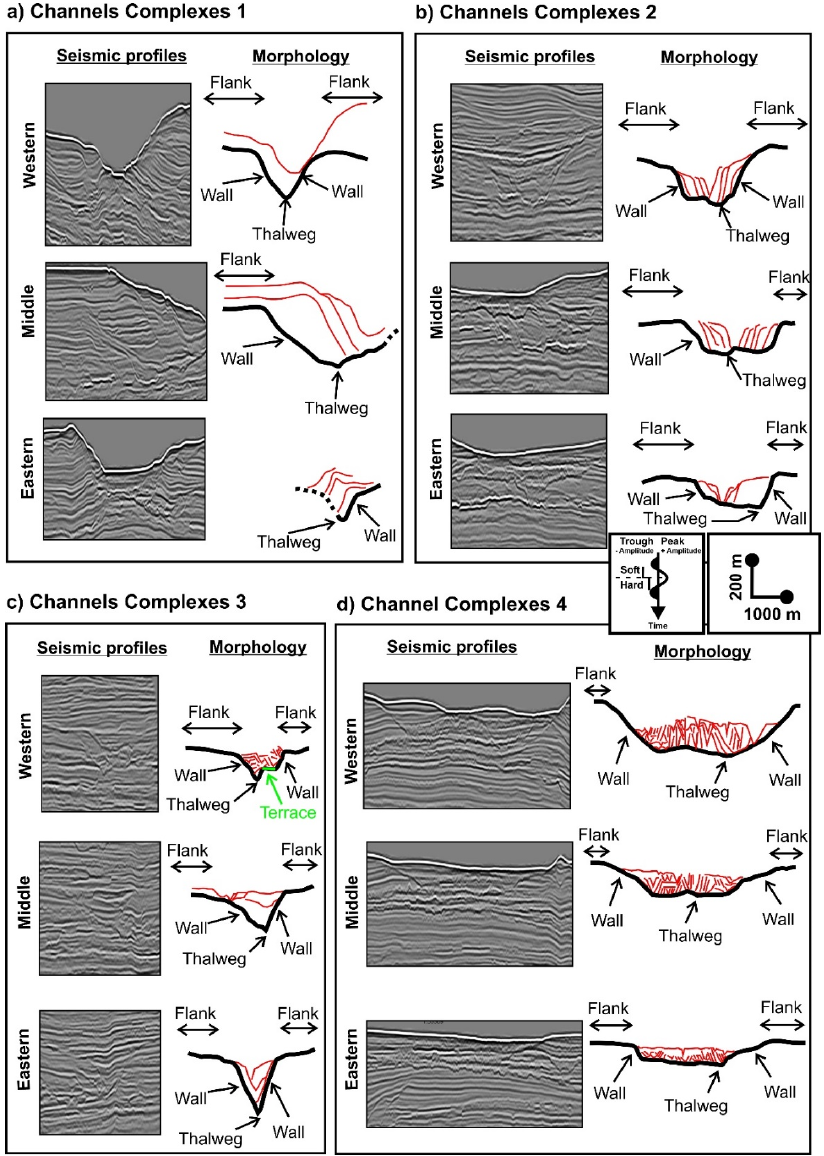
Figure 5. Erosional surface morphology of the channel’s complexes and the seismic profile of each representative channel complexes in the study area represent sediment transport direction from west to the east. Note that the dashed line is the interpreted position of the erosional surface before it is cut out by the younger channel, while the red line is the younger